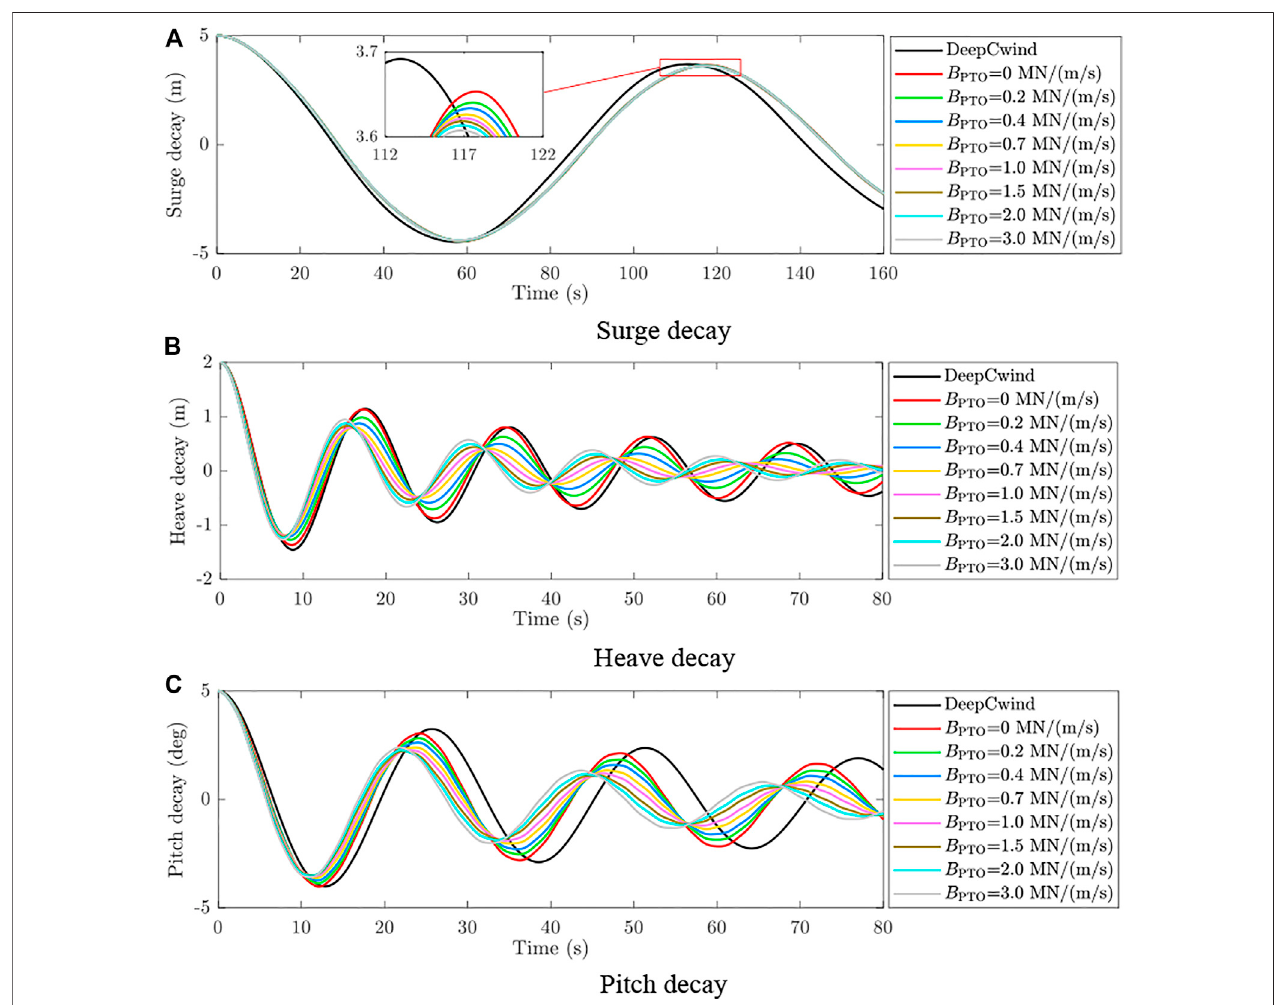
FIGURE 7 | Time series of free decay tests with different PTO dampings. (A) Surge decay. (B) Heave decay. (C) Pitch decay.